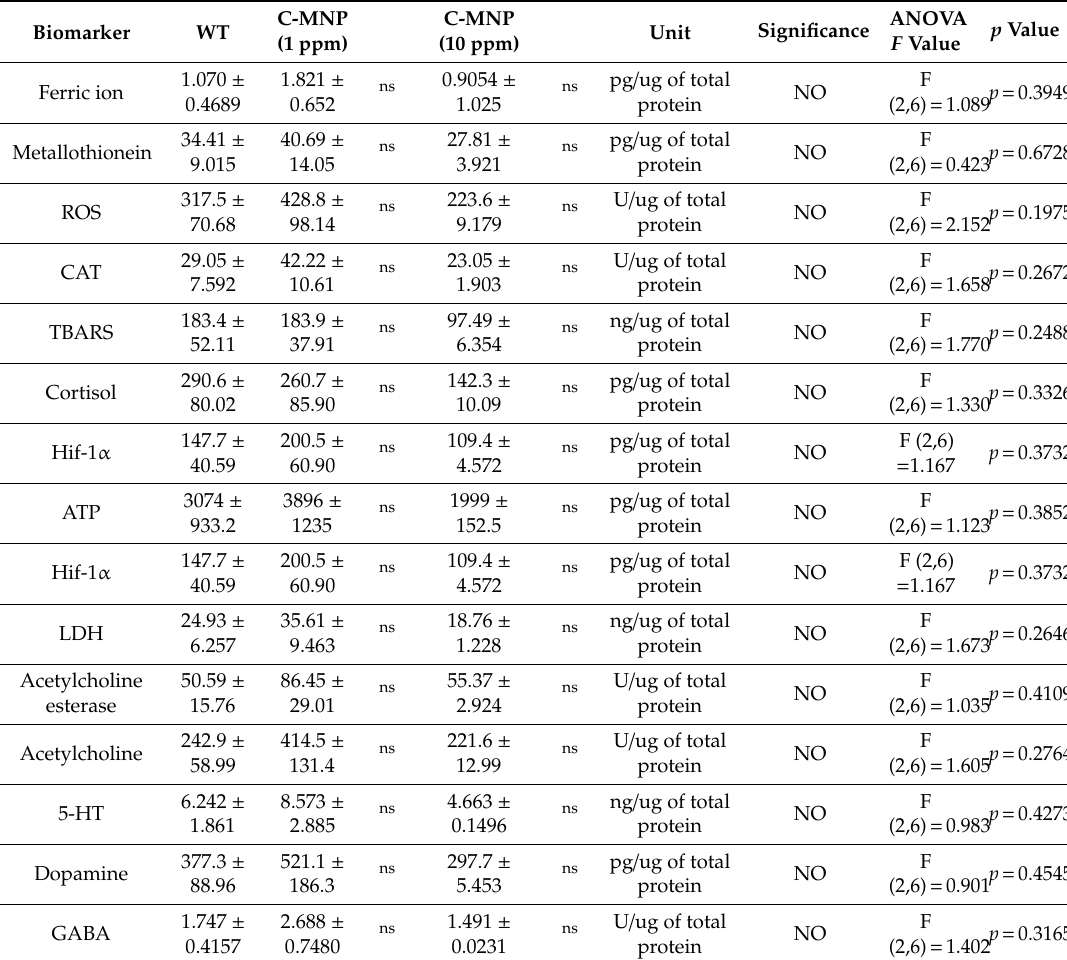
Table 1. Comparison of biomarker expression in the brain for carbon-coated magnetic nanoparticles (MNPs) exposed zebrafish. Data are expressed as the mean ± SEM. ns = not significant and tested by one-way ANOVA.